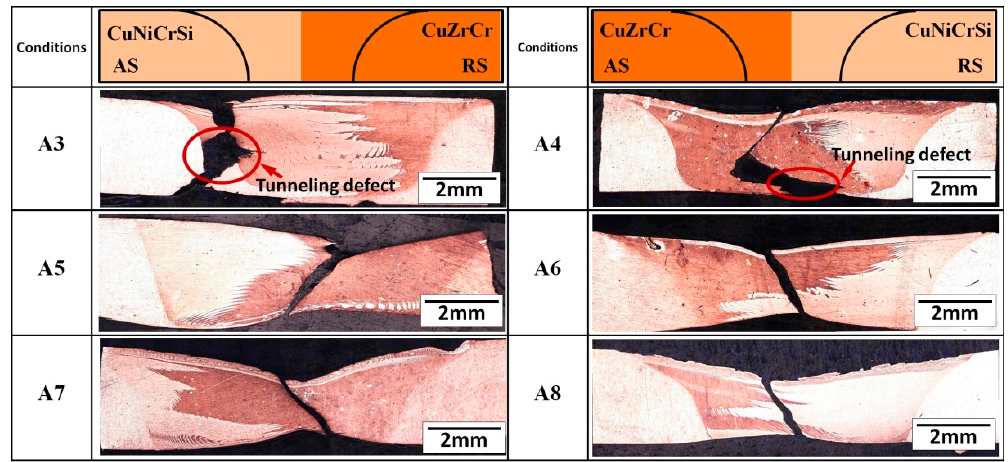
Figure 11. The failure locations of tensile testing specimens under the different conditions A3–A8.